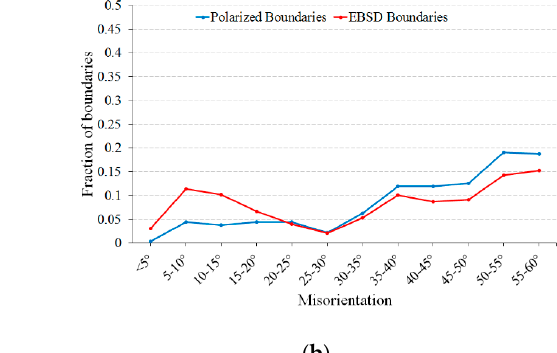
Figure 8. Number of identified boundaries ( a ) and fraction of boundaries ( b ) based on the misorientation angles, thixocast sample.